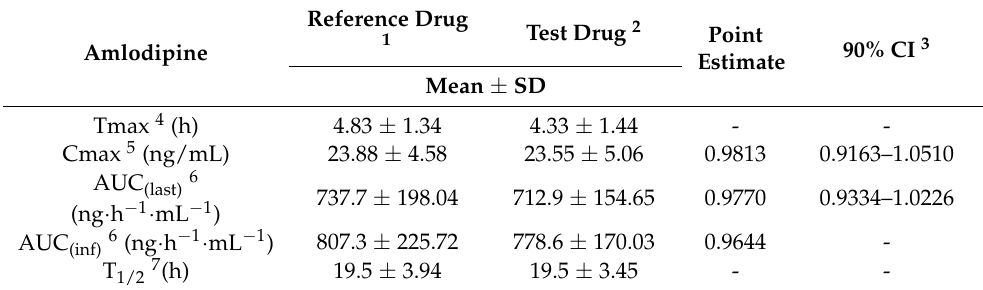
Table 5. Pharmacokinetic parameters of Twynstar ® and TA tablets at a dose of 5 mg amlodipine base in beagle